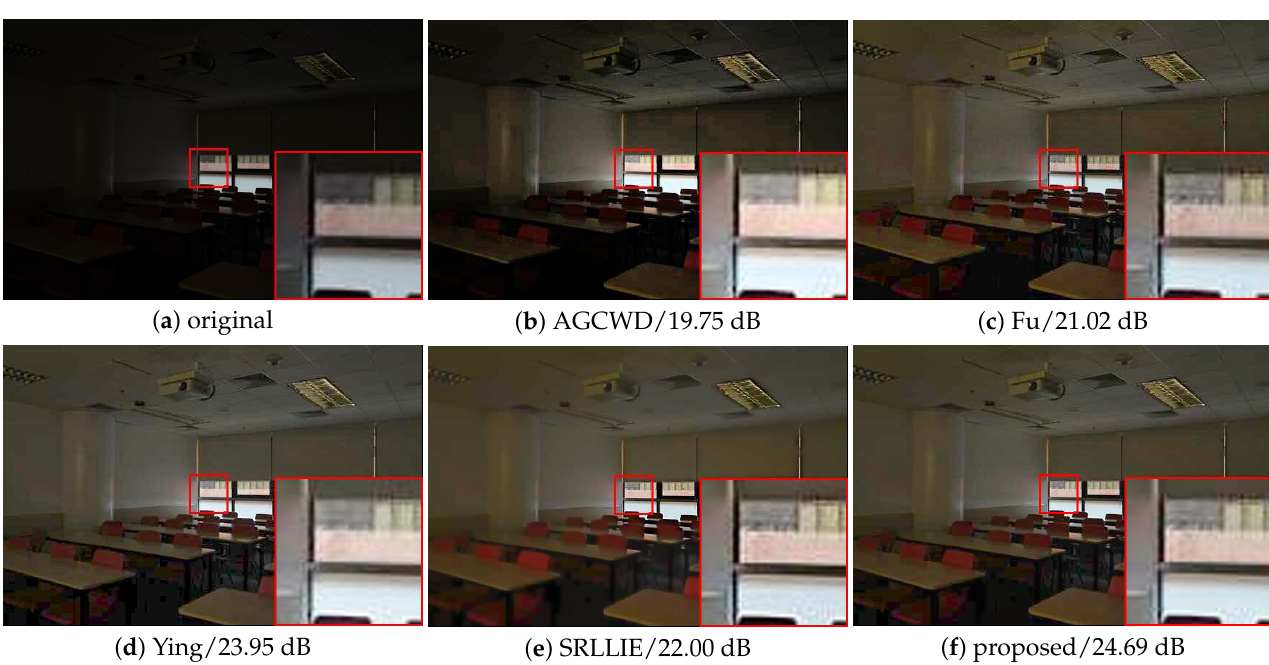
Figure 10. Enhancement effect of each method on the typical low-light image selected from